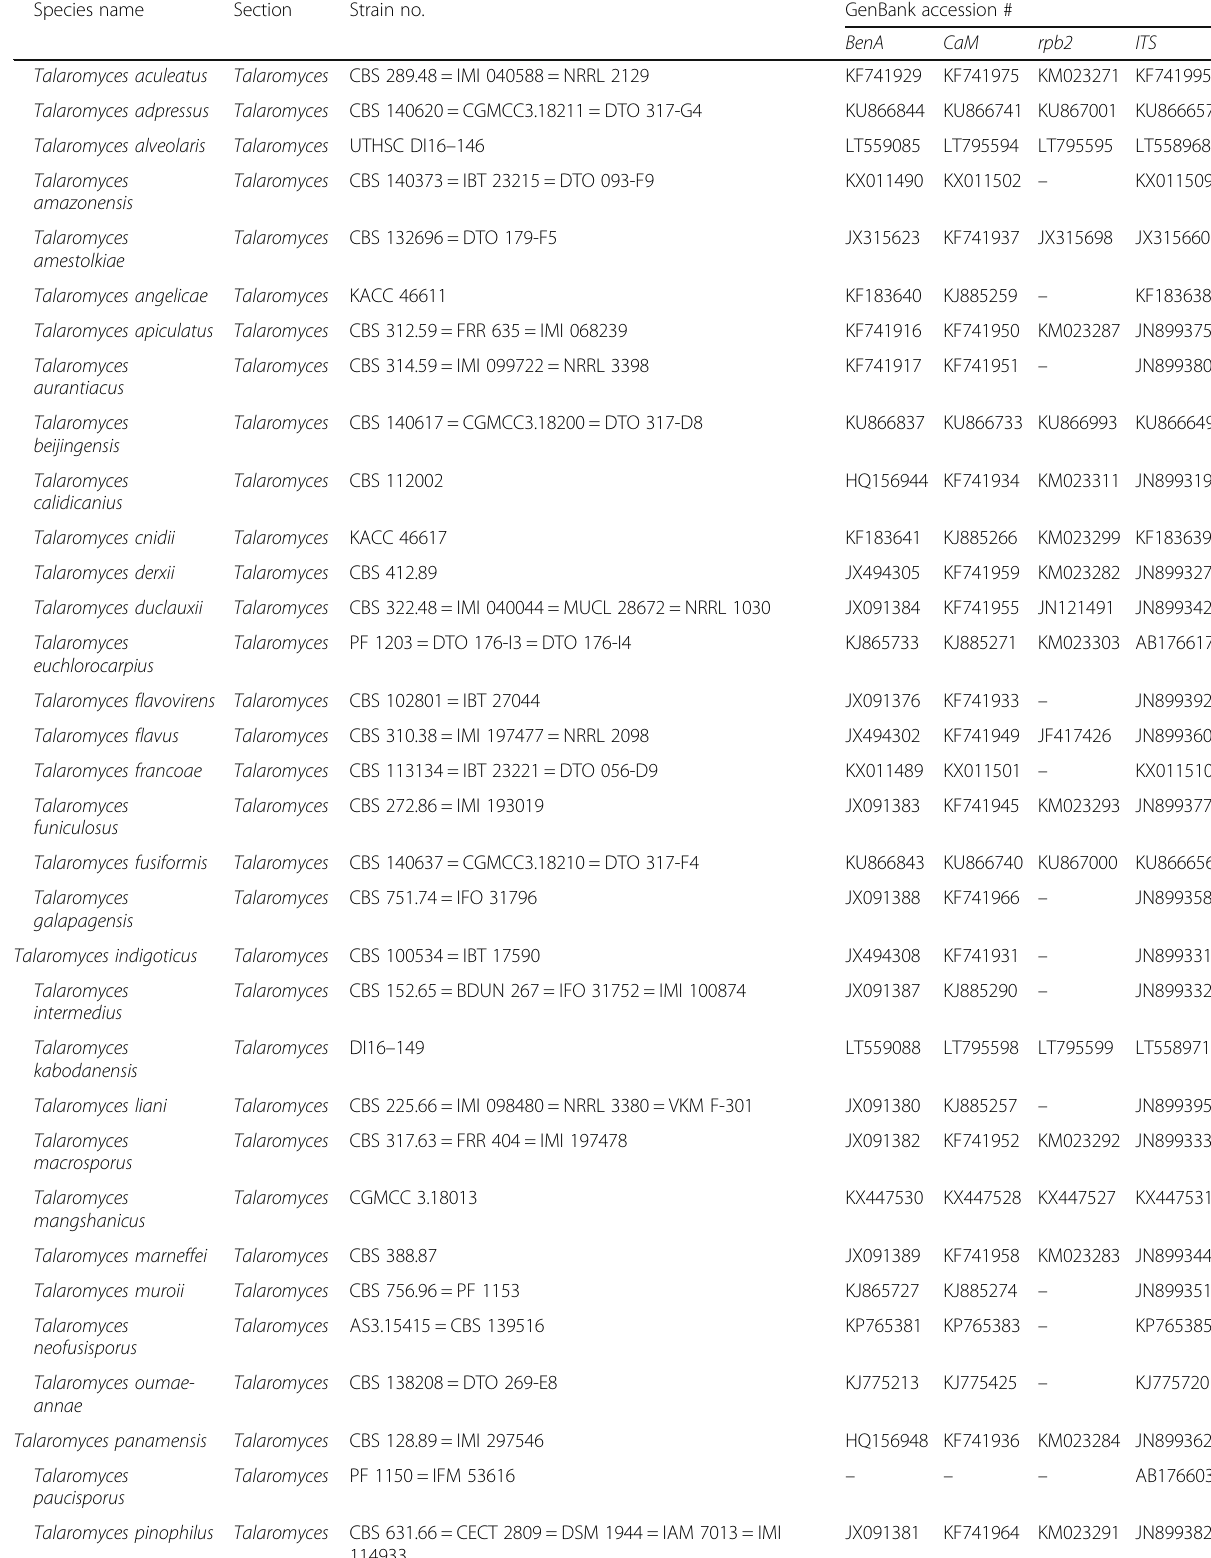
Table 2 Talaromyces spp. nucleotide sequences employed to build a phylogram to locate phylogenetically our strains from